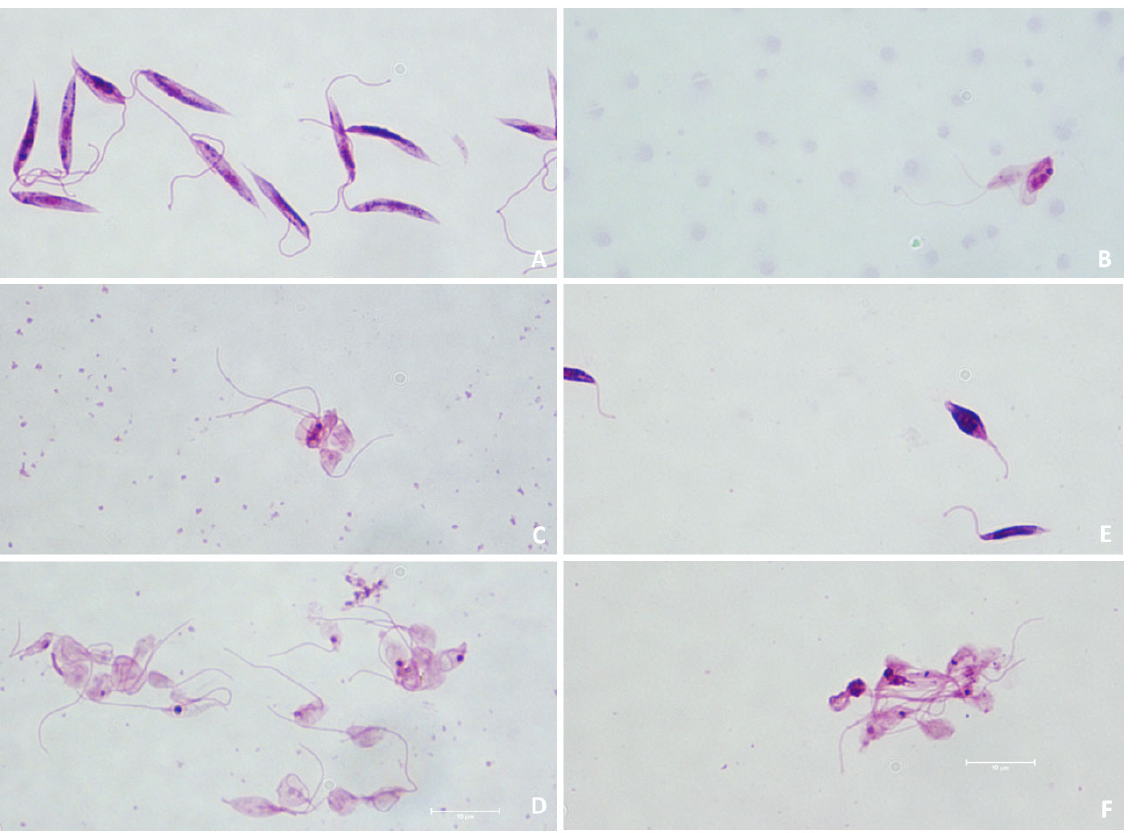
Figure 7. Assessment of L. tropica promastigotes morphology after 48 ‐ hours of treatment with 300 μ M of OZ1 ( C , D ), 200 μ M of OZ2 ( E , F ), and 0.625 μ M of amphotericin B ( B ); in comparison